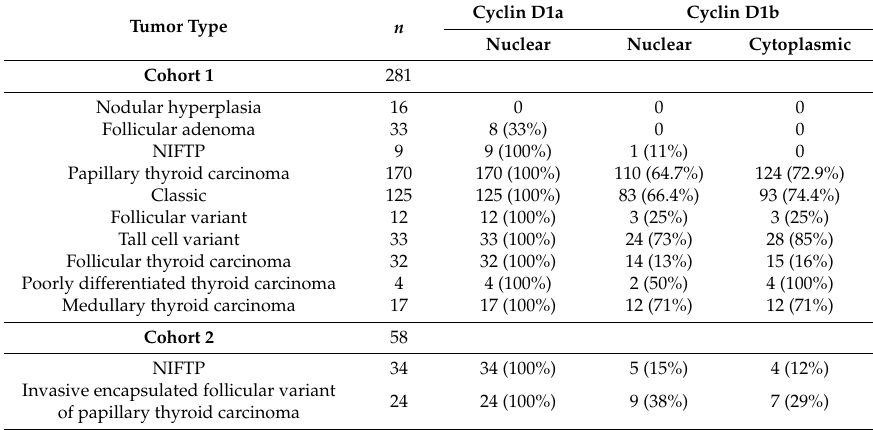
Table 1. Expression of cyclin D1a and cyclin D1b in thyroid tumors from cohort 1 and cohort 2.